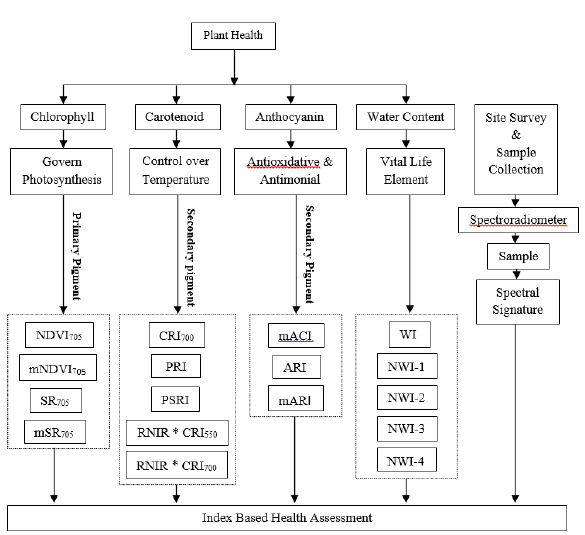
Figure 4.Methodology adopted for tree health assessment As shown in the figure 2, laser gun is directed towards mango leaves in different envelop and spectral response is visualized over LCD display of control panel. The data are stored for future reference once they satisfy the stability. SVC PC Data Acquisition software is used for the visualization and processing of the resulted spectral responses. Now sequentially each selected sample spectral indices method is implemented and results are computed.